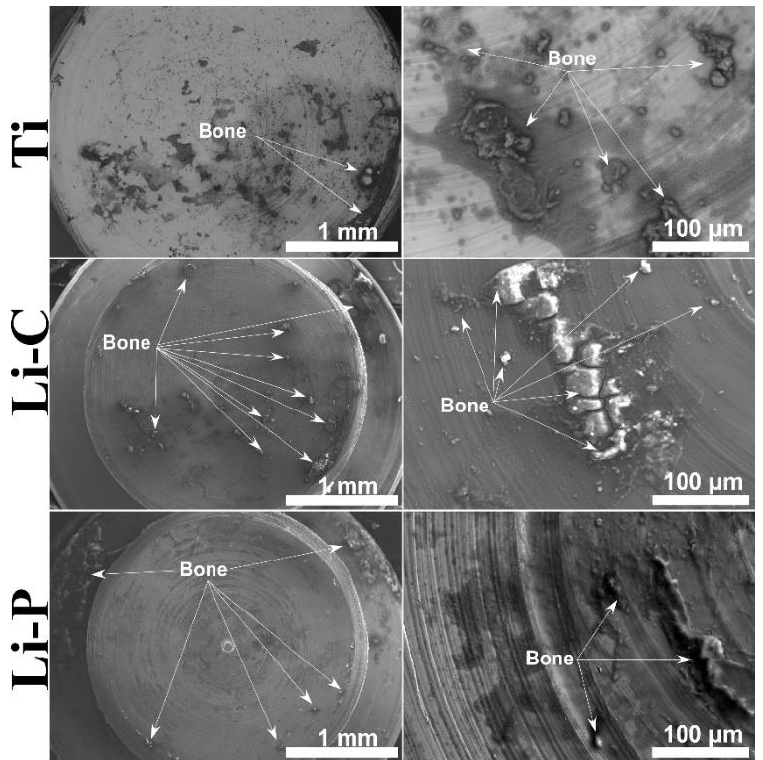
Figure 3. SEM micrographs indicating bone detachment on the surface of a control and functionalized (with Li-C and Li-P coatings) Ti implant, at 4 weeks after surgery.